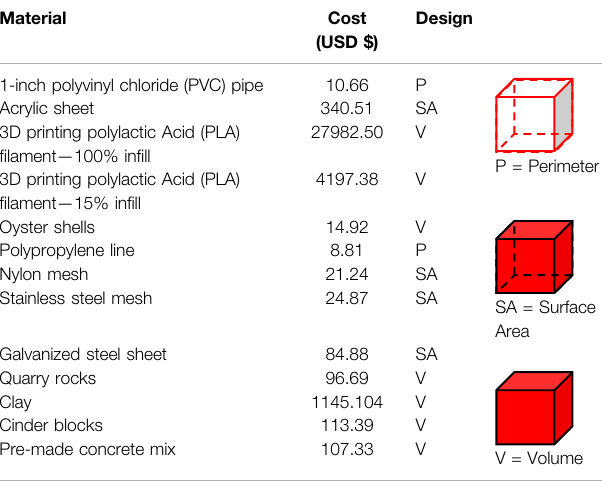
TABLE 3 | Cost associated with creating a 1 m 3 structure using the 3D-SPMC method and eight other materials commonly used for AH design (cost estimates based on average materials costs in the year 2020). The amount of material required for each design depends on the material type and its method of use, as indicated by red shading in the diagram below (P = Perimeter, SA = Surface Area, V = Volume).